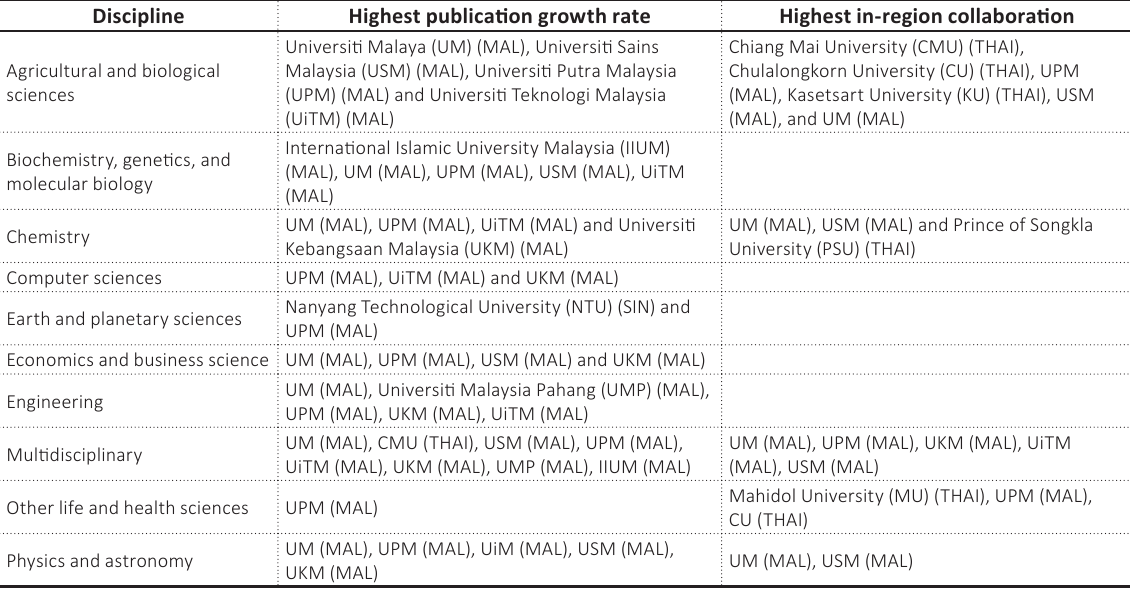
Table 5. Top ASEAN universities in publication growth rate and in-region collaboration in selected